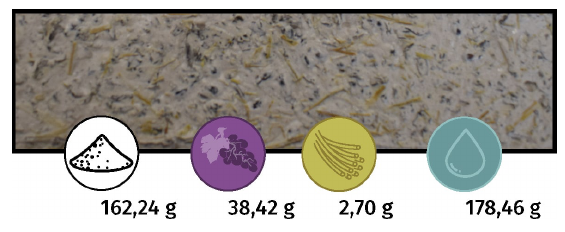
Table 2. Mix-design prototype 1.